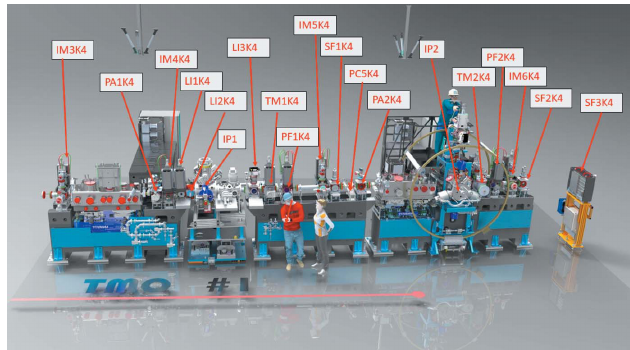
Figure 3 Overview of the TMO instrument layout, showing both endstations which are capable of taking full advantage of both the high per-pulse energy from the copper accelerator (120 Hz) as well as high average intensity and high repetition rate from the superconducting accelerator (1 MHz). Indicated are the beam-position monitors IM3K4, IM4K4, IM5K4, IM6K4; differential pumping sections PA1K4 and PA2K4; IP1 optical laser in-coupling LI1K4, LI2K4, and IP1 laser out-coupling LI3K4; the arrival-time monitors TM1K4 and TM2K4; wavefront sensor PF1K4 and PF2K4; retractable beam terminators SF1K4 and SF2K4; beamline collimators PC5K4; as well as the interaction points IP1 and IP2; and finally the beam terminator SF3K4.